Question: Summarize what this figure shows in one sentence.
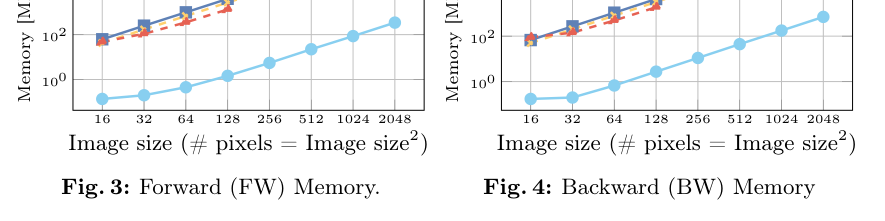
Answer: Lightplane Renderer memory & speed benchmark showing the forward (FW and backward (BW) passes of Lightplane Renderer, compared to the Autograd renderer, Checkpointing (Pytorch checkpointing on Autograd renderer), and NerfAcc Instant-NGP (Instant-NGP [56] implemented in NerfAcc [44], which is claimed 1.1× faster than the original version) Lightplane exhibits up to 4 orders of magnitude lower memory consumption at comparable speed. All axes are log-scaled.